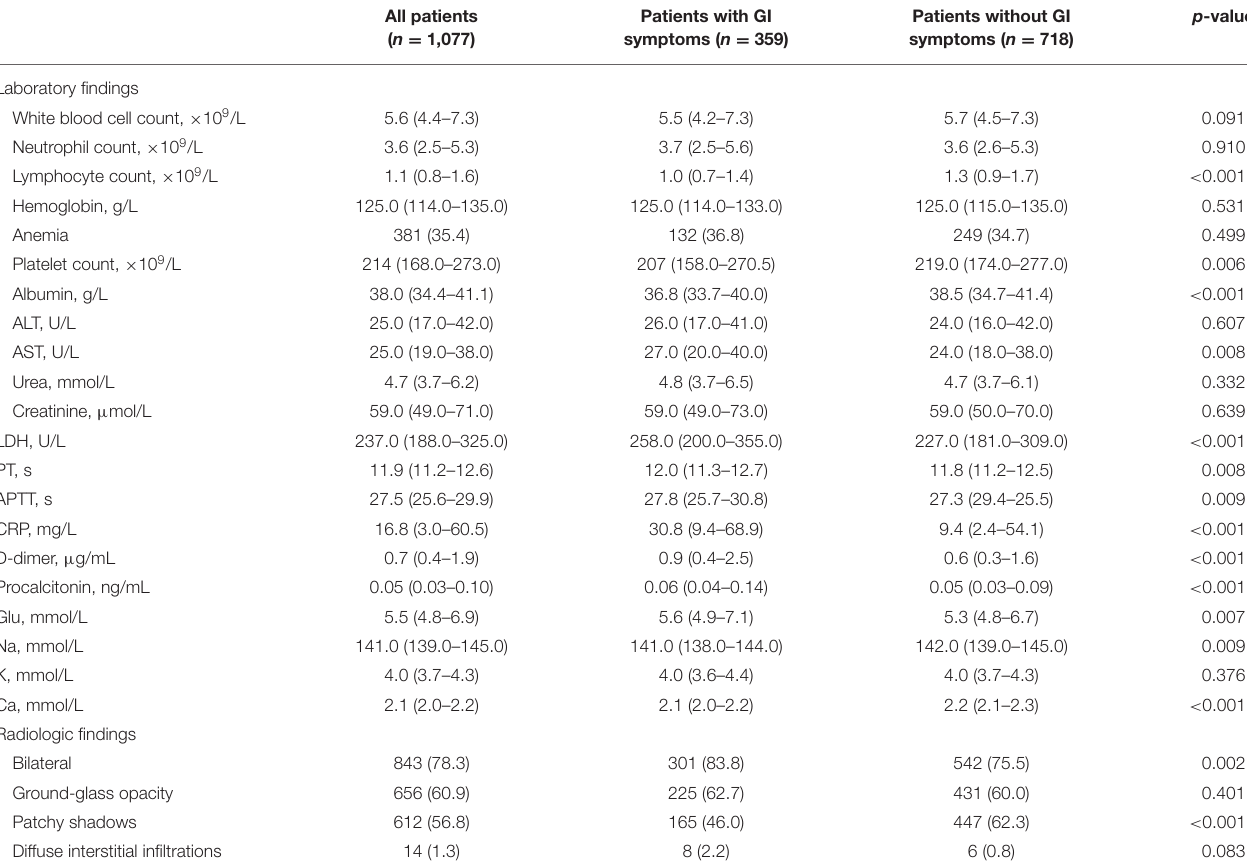
TABLE 3 | Laboratory and radiographic findings of patients with COVID-19 with and without GI symptoms.